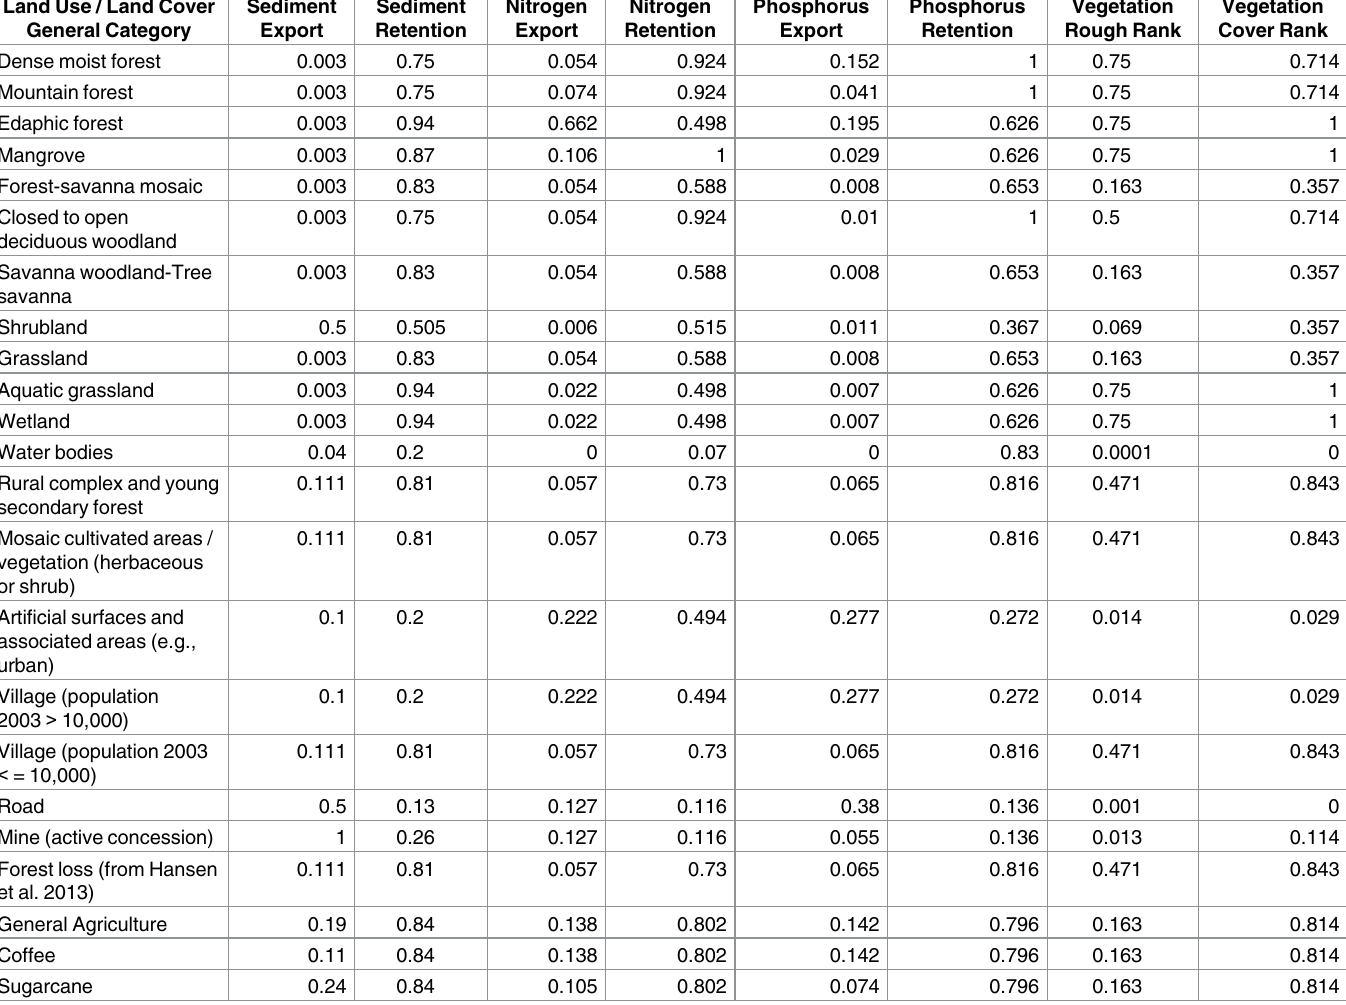
Table 1. Normalized land use / land cover coefficients for the RIOS modeling. Based upon coefficients determined from literaturereview from [24, 25]. More land use / land cover categoriesare listed here than in Fig 2, which groups multiplesimilar categories for displaypurposes(e.g., Agriculture). Higher val- ues represent a greater level of impact for that factor (e.g., the highestsedimentexport value corresponds to the highestrelative level of export across all land use / land cover categories). Land Use / Land Cover General